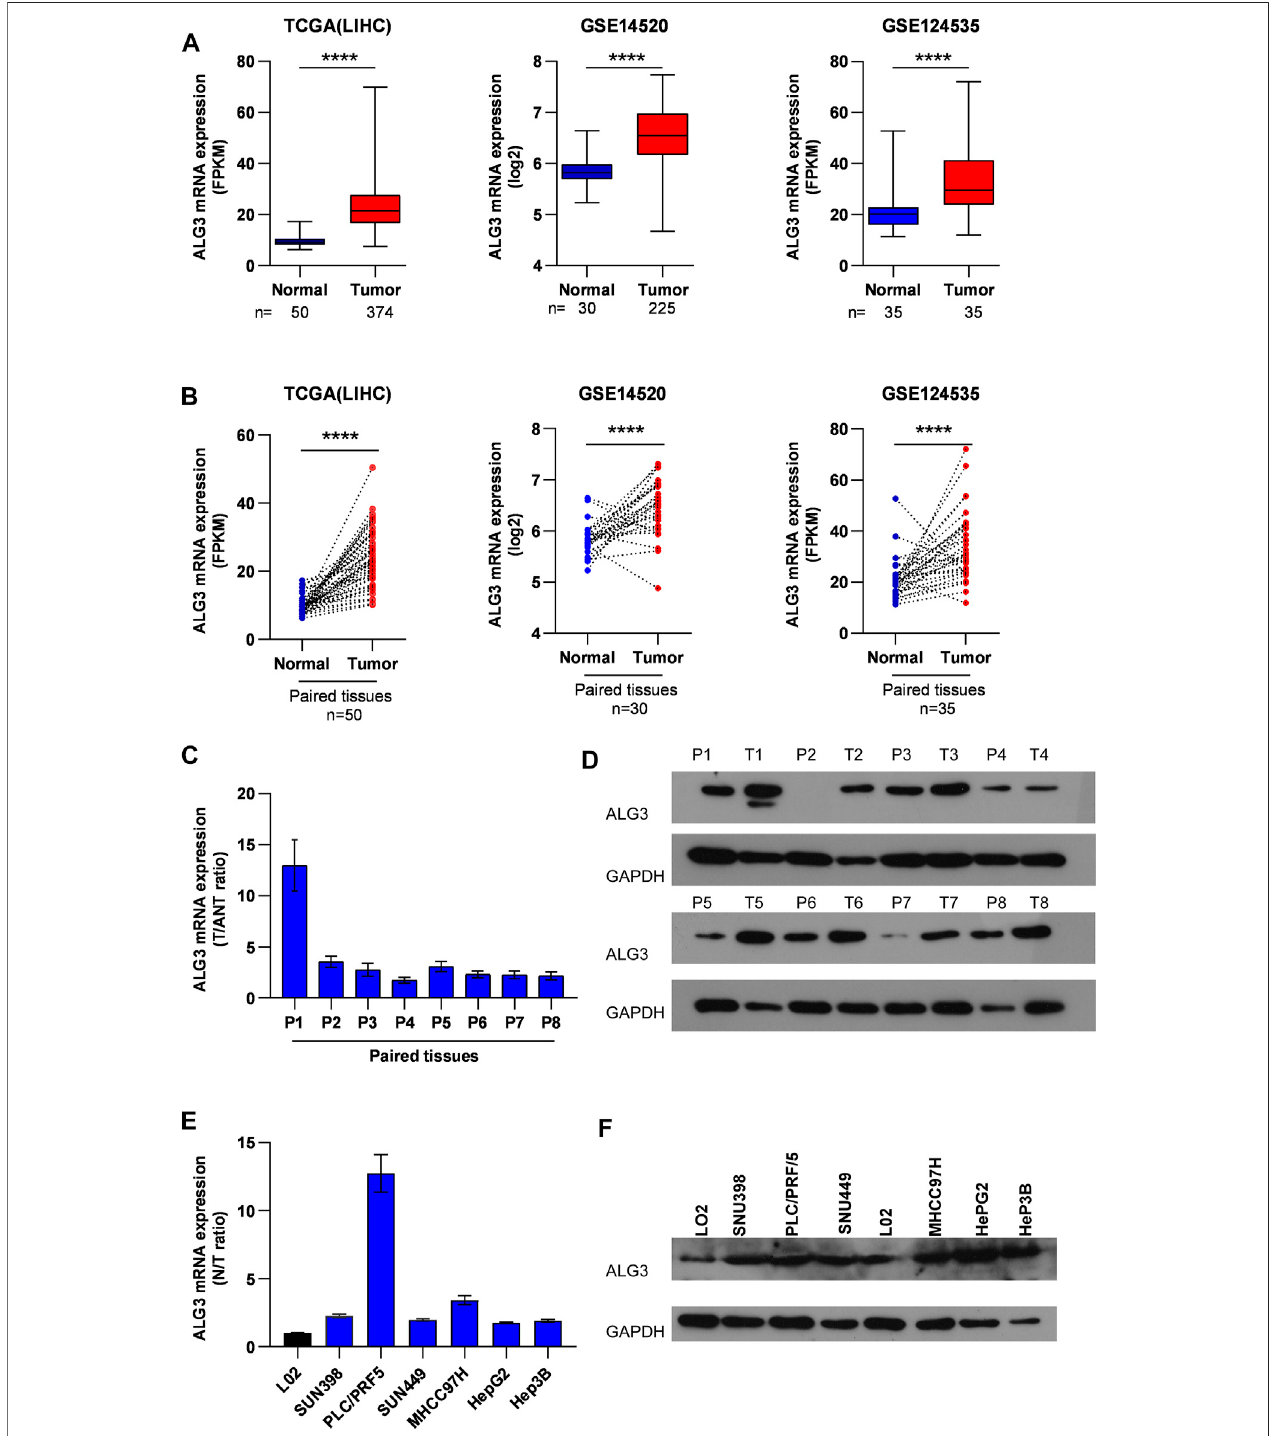
FIGURE 2 | Upregulation of ALG3 in HCC. (A) ALG3 mRNA expression levels were markedly overexpressed in unpaired HCC tissues, as indicated by the TCGA LIHC dataset and GEO HCC datasets GSE14520 and GSE124535. (B) ALG3 mRNA was upregulated in paired HCC tissues and adjacent normal tissues in the TCGA LIHC dataset and GSE14520 and GSE142535 datasets. RT-PCR (C,E) and WB (D,F) analysis of ALG3 expression in paired HCC tissues and non-tumor adjacent tissues and in the liver cancer cell line. GAPDH was used as a loading control. (** p < 0.01, *** p < 0.001, and **** p < 0.0001)